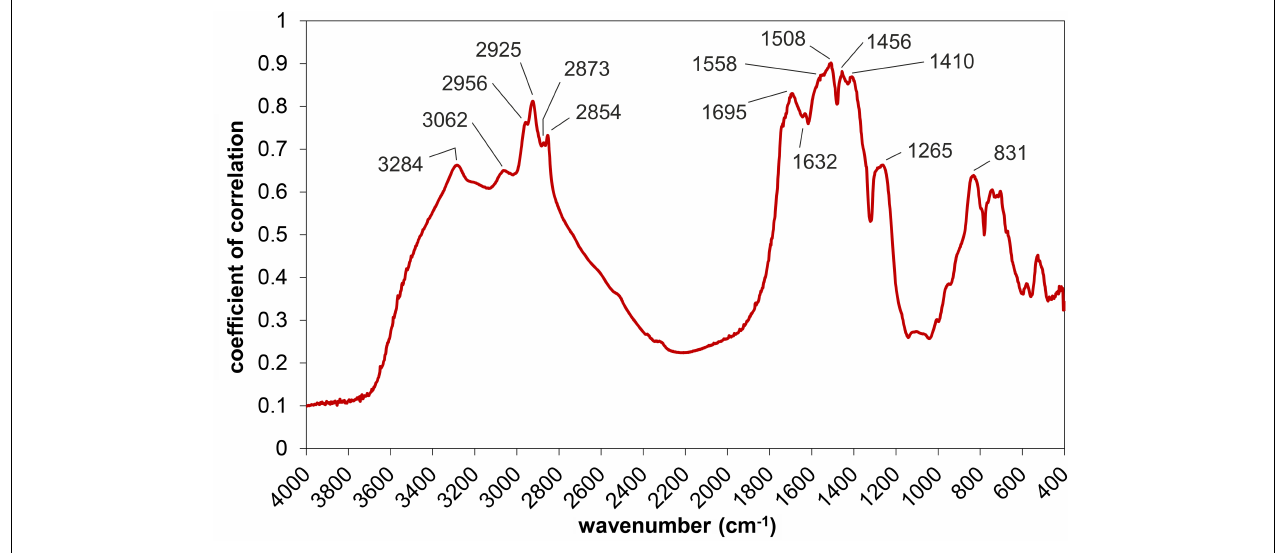
FIGURE 7 | Correlation spectrum expressing collinearity between the amount of adsorbed Ni and the absorbance detected in the mid-infrared region ( r > 0.6 corresponds to the P < 0.05 significance